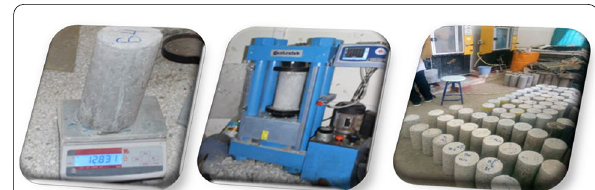
Fig. 17 Mechanical compressive strength tests R C28 .